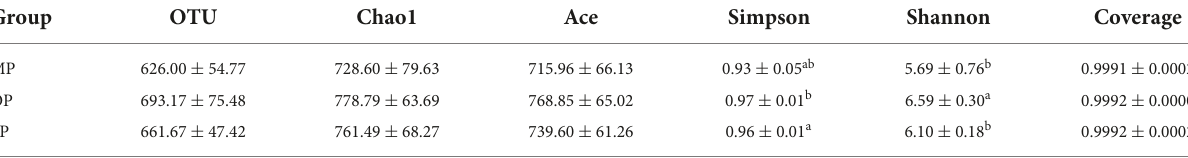
TABLE 1 Comparison of fecal microbial alpha diversity index at different stages of the menstrual cycle in rhesus monkeys. Group